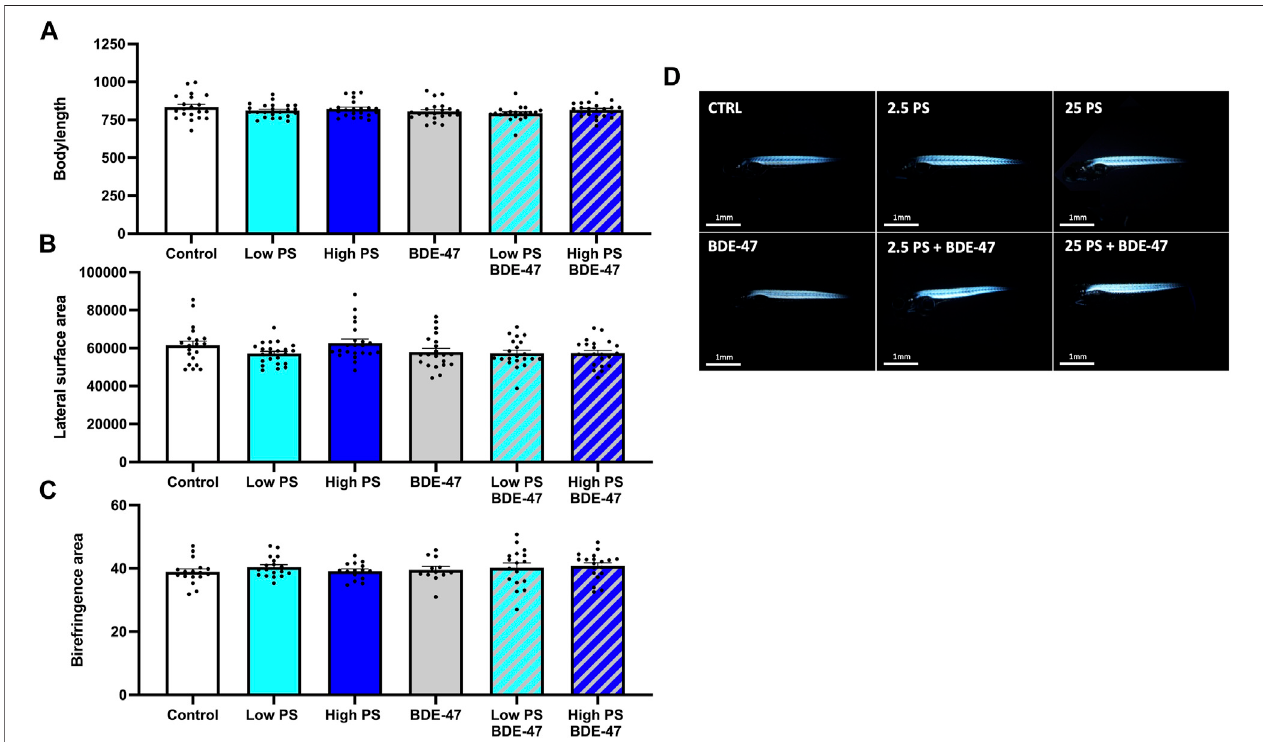
FIGURE 3 | Morphometric indices of 7 dpf zebra fi sh larvae exposed to vehicle control, 2.5 ppm PS, 25 ppm PS, 10 ppt BDE-47 or their combinations: Body length (A) ,lateralsurfacearea (B) andbirefringentlateralsomitearea (C) .Individualmeasurementsandaveragedata+S.E.M.from n =3replicateassayswithcombined n = 20 – 23 (A,B) and n = 12 – 19 (C) per treatment group are presented. Representative images of birefringence measurements of laterally positioned zebra fi sh are presented (D) . Data were analyzed using a one-way ANOVA with a signi fi cance cut-off of p < 0.05.